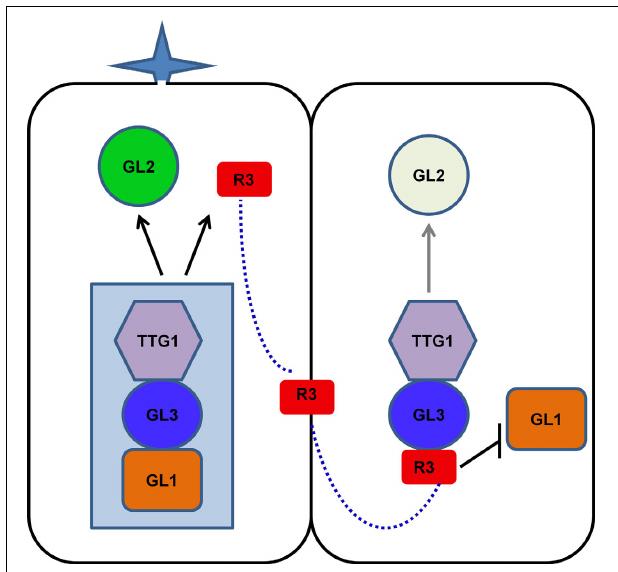
FIGURE 3 | Model of action of R3 MYB transcription factors in controlling trichome formation. TTG1, GL3/EGL3, and GL1 form an activator complex to regulate the transcription of GL2 and R3 MYB genes. R3 MYBs can move from a trichome precursor cell (left) to its neighboring cell (right) to compete with GL1 for binding GL3 or EGL3, thus limiting the activity of the TTG1-GL3/EGL3-GL1 activator complex and resulting in decreased expression of GL2 . In addition, some R3 MYBs, such as TCL1 and TCL2, can suppress the transcription of GL1 . These events create differences between cells and ultimately result in a pattern of trichome and non-trichome cells. For simplicity, EGL3 is not shown in the model. R3, R3